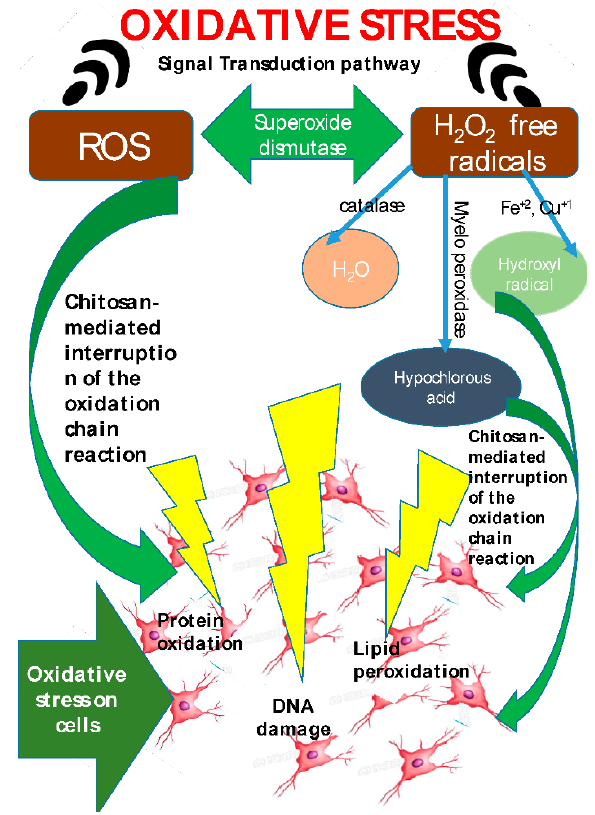
Figure 8. Mechanism of anti-oxidative property exhibited by chitosan (taken from [12] under Creative Commons License).